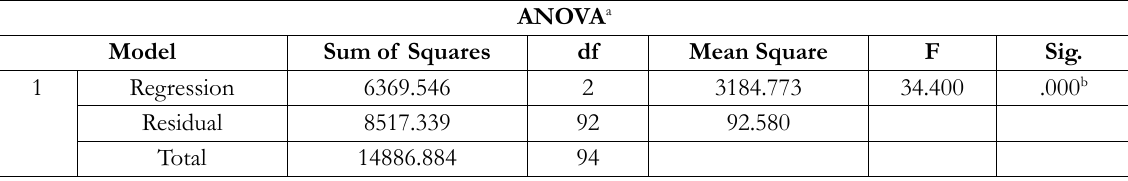
Table 7. Regression results of independent variables with intervening